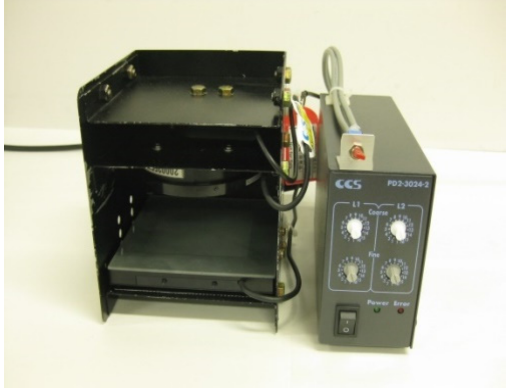
Figure 5. Appearance of the experimental